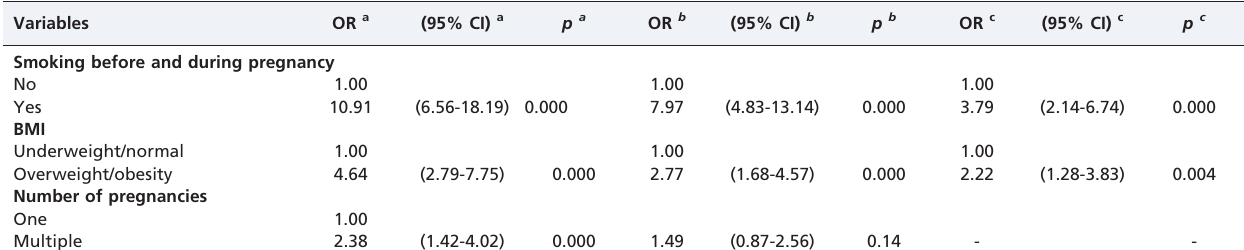
Table 3 - Multivariate analysis of the association between smoking, body mass index, pregnancies, and periodontitis in pregnant women from Recife, Brazil, 2008.